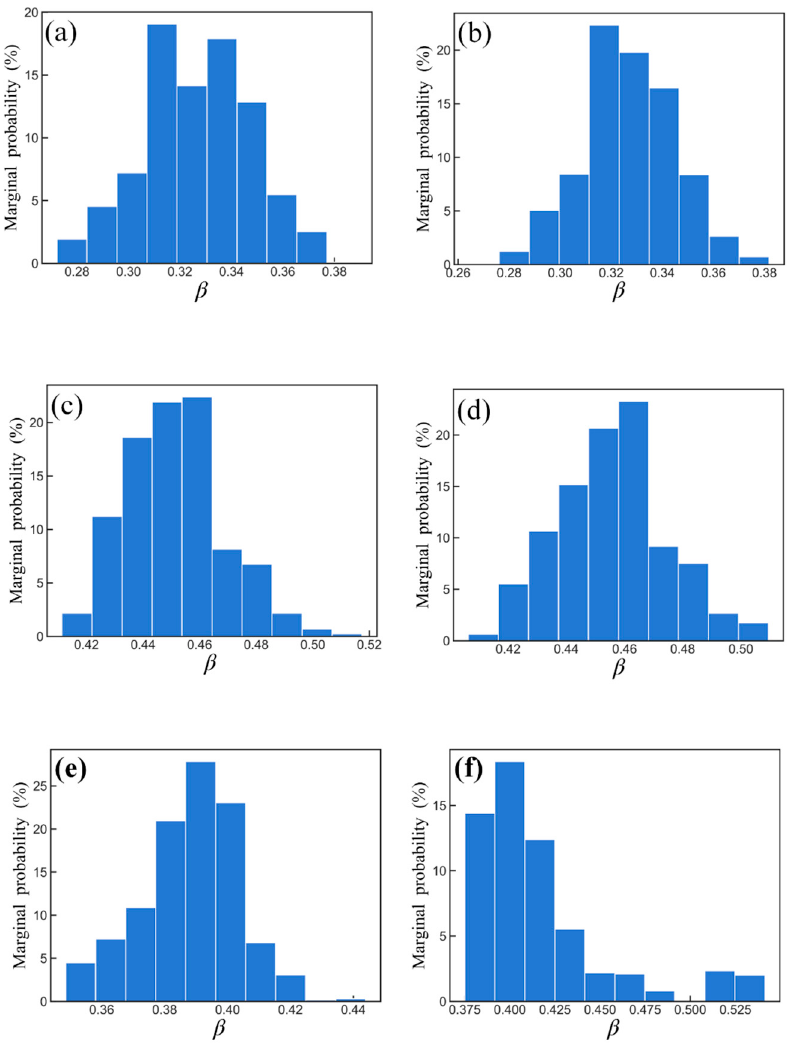
Figure 7. Posterior distributions of β using Hd_0 (left) and Hd_S1 (right) at the Hanjiang River catchment ( a , b ), the Xiangjiang River catchment ( c , d ), and the Ganjiang River Catchment ( e , f ).